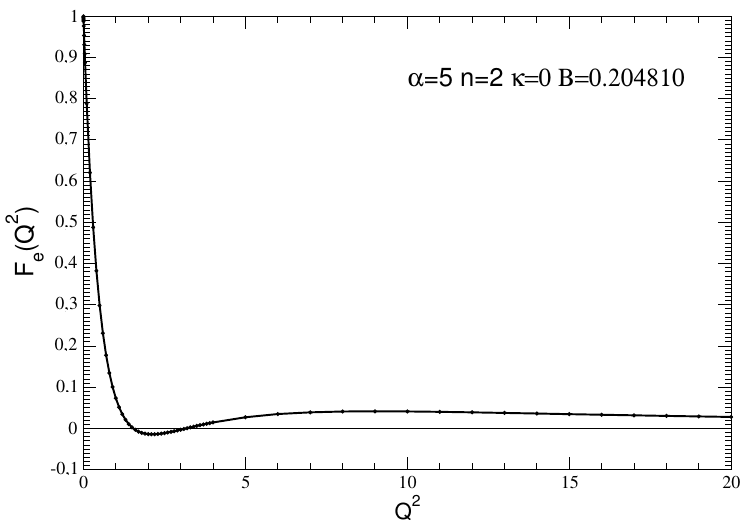
Figure 12. Elastic form factor of the normal excited state with n = 2, κ = 0—No. 2 from Table 1. (Adapted from [1]).